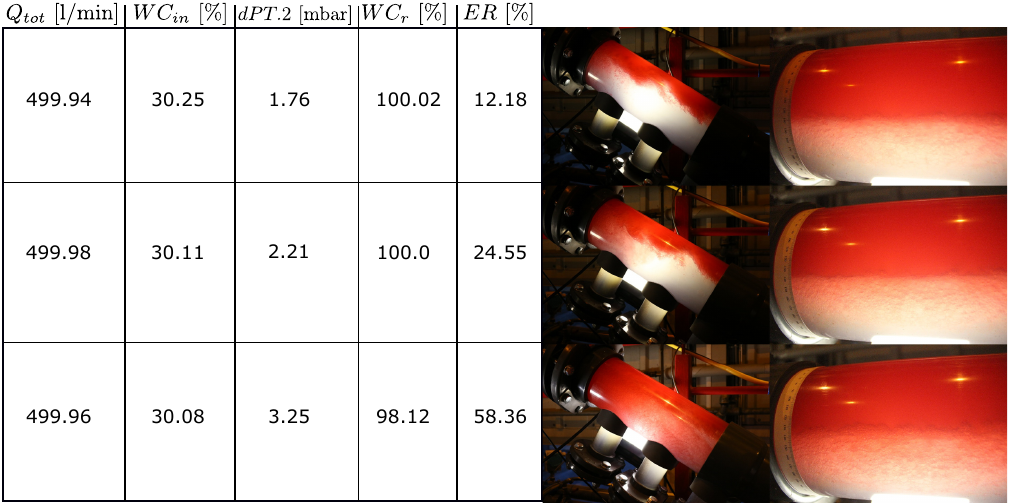
Figure A3. 500 L/min inlet flow and 30% water